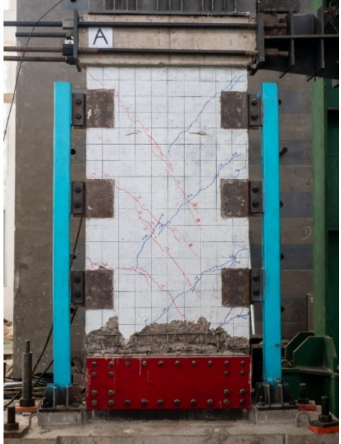
Figure 24. Web crushing failure of PC wall with long limited slippage vertical connection (blue and red lines represent the cracks as subjecting to different loading direction)